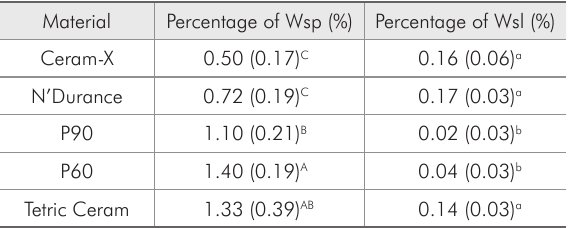
Table 2 - Percentage of water sorption and solubility ob- tained after 28 days immersion in deionized